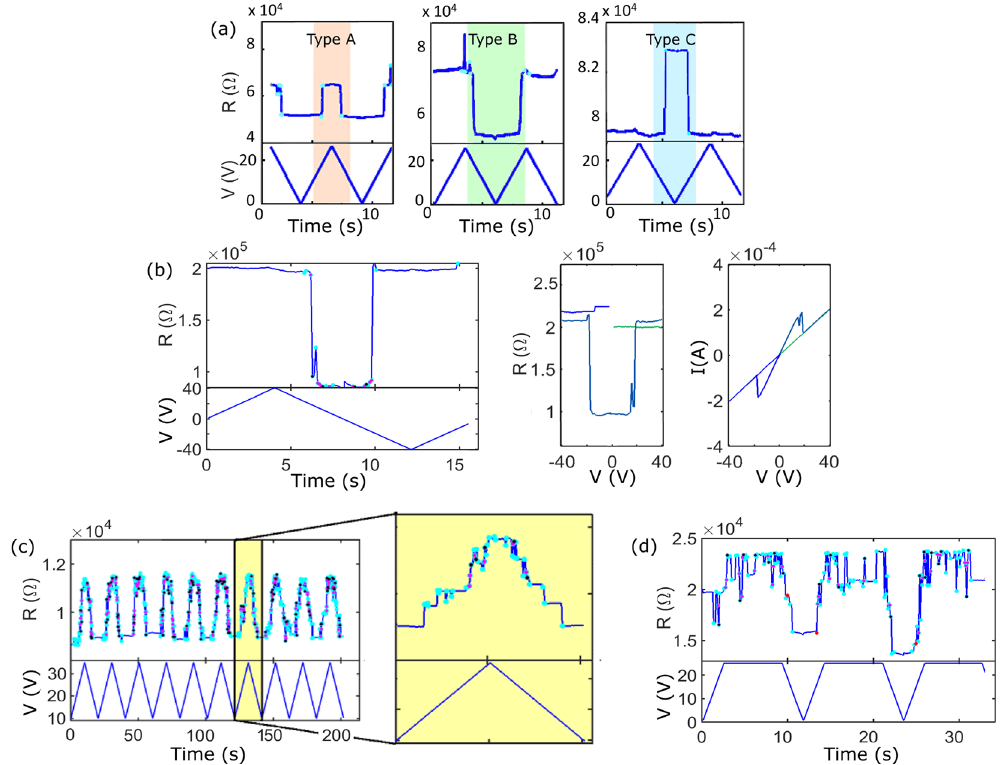
Figure 2. Examples of characteristic switching events. (a) The three simplest types of events are reported: resistance increase at high voltage (pink region); resistance decrease at low voltages (green region); and resistance increase at low voltage (blue region). These archetypes are referred to as Type A, B and C respectively. (b) Example of bipolar switching occurring while the voltage is ramped between positive and negative V max values. The R(t), R(V) and I(V) curves are shown. (c) Examples of highly reproducible sequences of multiple overlapping switching events on consecutive cycles resulting in ‘anti-potentiation’; in the inset: multiple well-